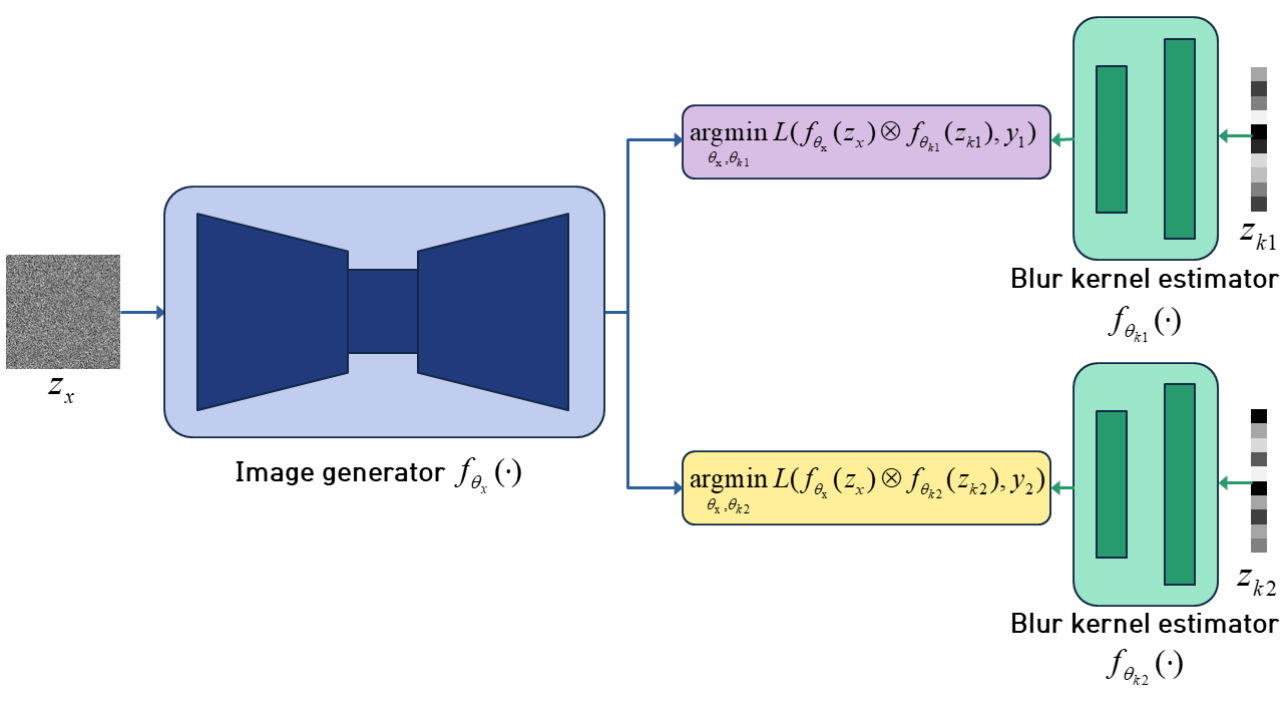
Figure 2. Architecture of the proposed DualDeblur. . We adopt Unet [7] with a skip connection as the architecture of f θ . Conv2d represents a 2D Table 1. Architecture f θ x x convolution operation, “lReLU” denotes a leaky ReLU, and denotes the channel-wise concatenation. Kernel ( m , n n , p ) ⊕ × represents the number of filters m , filter sizes n n , and padding p . We implement downsampling with stride 2 and × upsampling with bilinear interpolation. C represents image channels, and W x H x the image ×